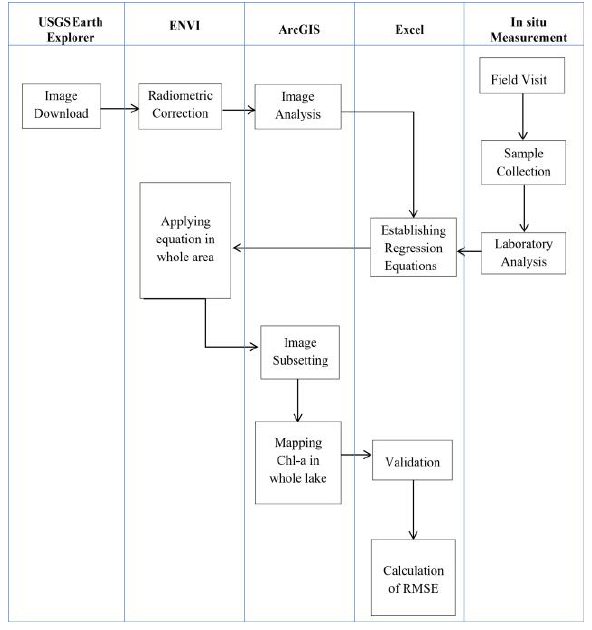
Figure 1. The workflow of the study